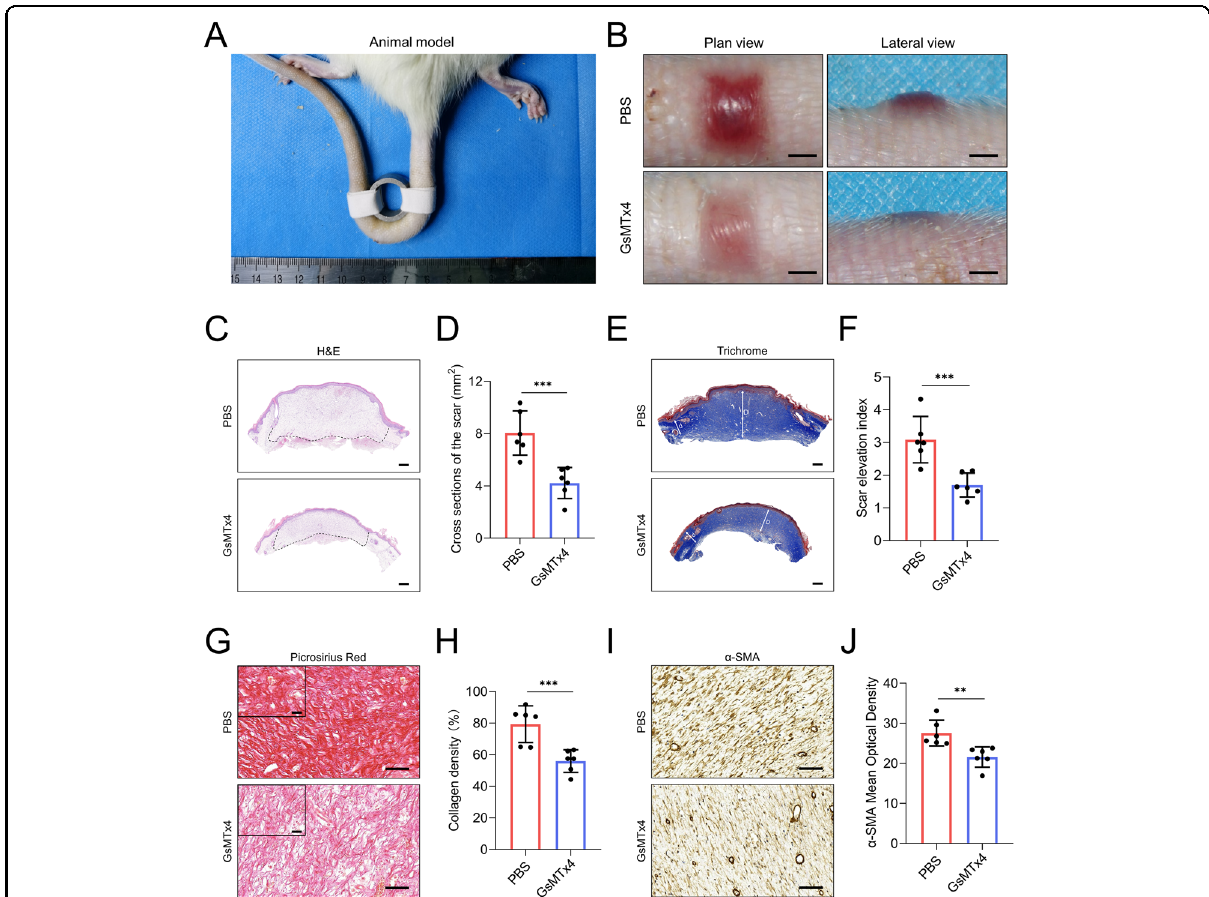
Fig. 5 GsMTx4 attenuates excessive scarring in a stretch-induced rat tail model. A Animal modeling of stretch-induced scarring in rat tail. B Images of scar appearances and elevations in the PBS-treated group and GsMTx4-treated group (Scale bar = 2 mm). C , D Images and quantitative analysis of cross-sections of scar in PBS-treated group and GsMTx4-treated group. (Scale bar = 500 μ m). E , F Images and quantitative analysis of SEI of scars in PBS-treated group and GsMTx4-treated group. (Scale bar = 500 μ m). The long arrow ‘ D ’ represents the thickness of hypertrophic scar tissues while the short arrow ‘ d ’ represents the thickness of adjacent normal skin tissues. “ scar elevation index ” is de fi ned as the D/d ratio. G , H Images and quantitative analysis of collagen density of scars in PBS-treated group and GsMTx4-treated group. (Scale bar = 50 μ m). Scale bars for the zoom images, 50 µm. I , J Images and quantitative analysis of α -SMA expression in PBS-treated group and GsMTx4-treated group. (Scale bar = 50 μ m). Arterioles were excluded from α -SMA quantitation. The results are expressed as the means with SD ( n = 6). T -test is used for all analysis. ** P < 0.01, *** P <